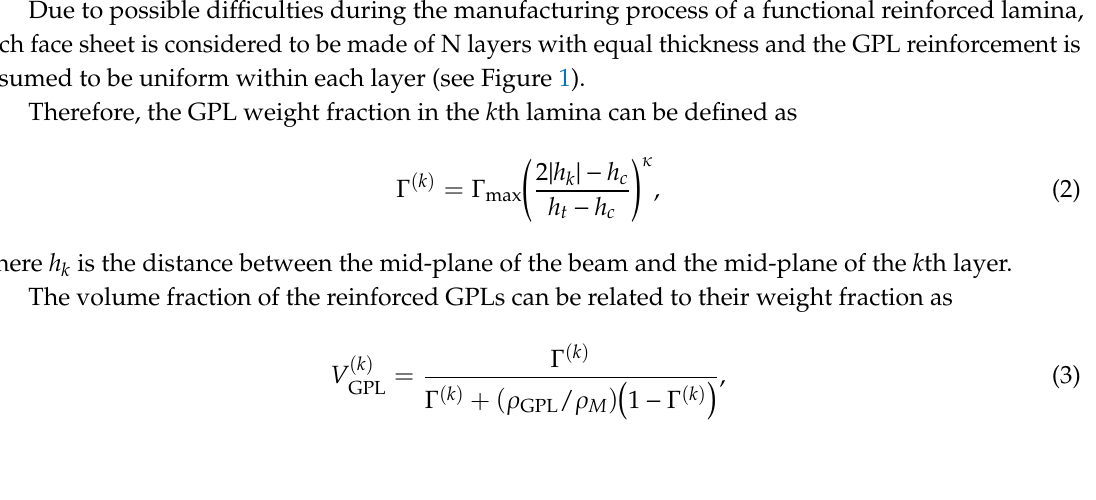
_ = (cid:1985) ((cid:1878)) (cid:1985) (cid:3029) ⁄ ) through the thickness of _ = (2(cid:1878) − ℎ (cid:3030) ) 2 ⁄ ℎ (cid:3033) ).